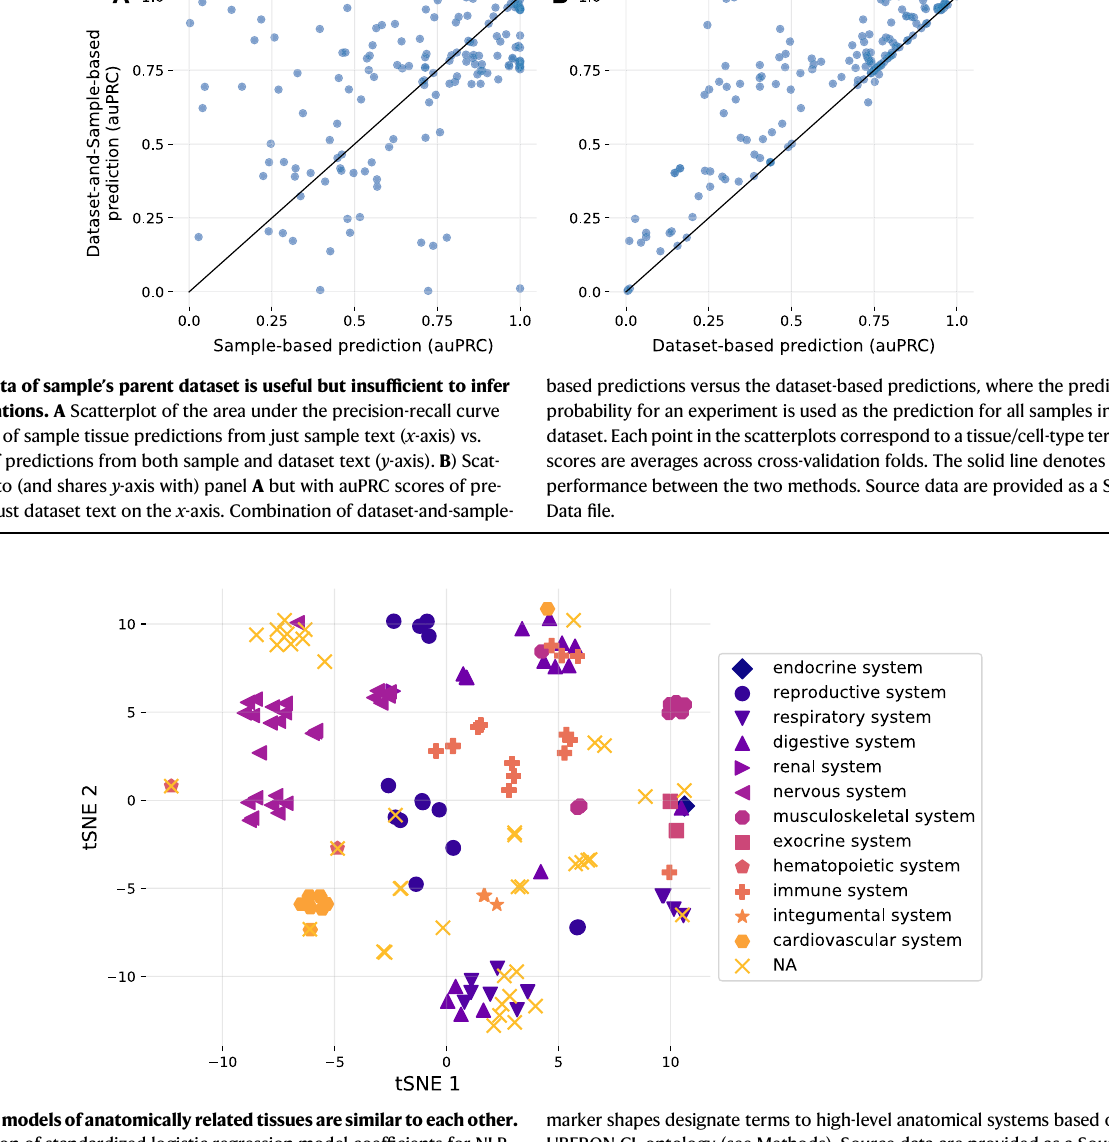
marker shapes designate terms to high-level anatomical systems based on the UBERON-CL ontology (see Methods). Source data are provided as a Source Data fi